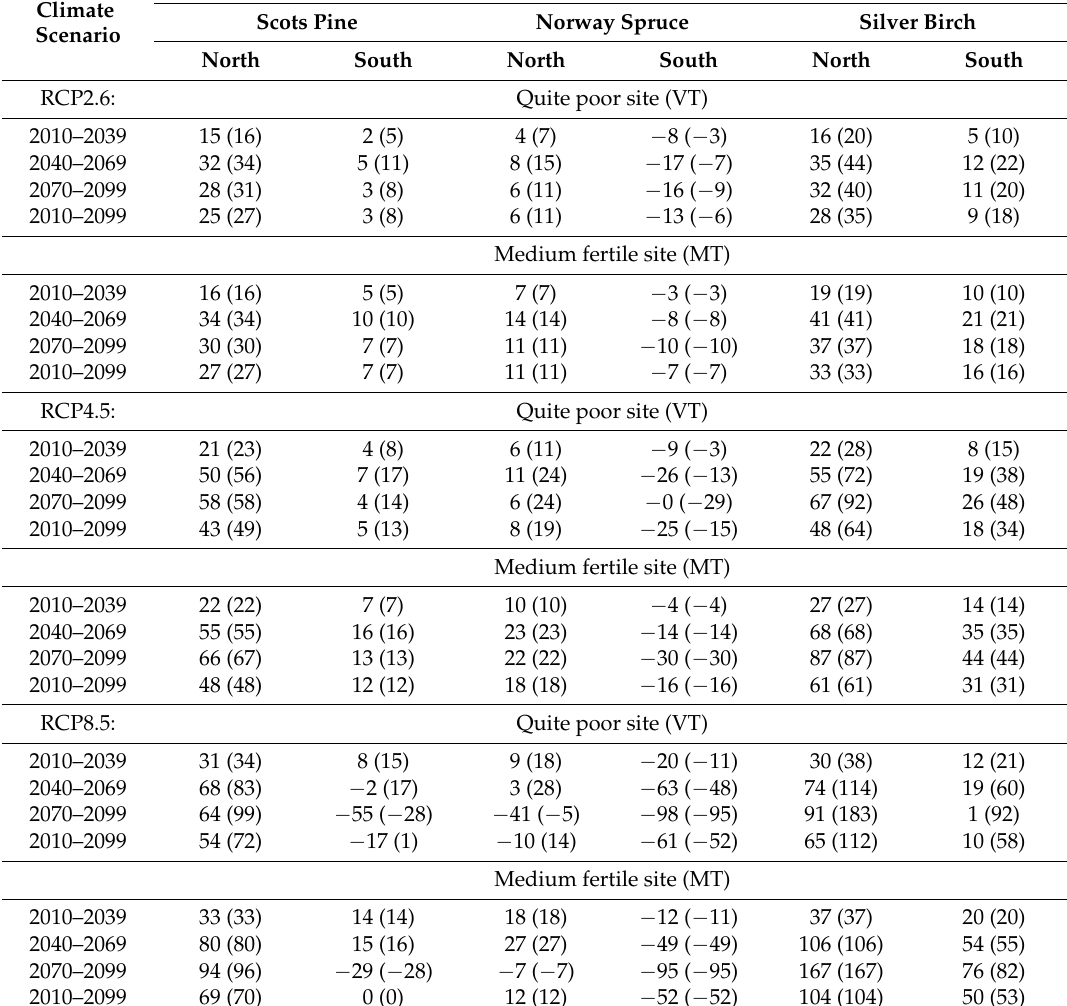
Table 5. Mean change in diameter growth on quite poor (VT) and medium fertile (MT) upland sites in different tree species in the south (Tampere, 61 ◦ N) and north (Rovaniemi, 66 ◦ N) under minor (RCP2.6), moderate (RCP4.5), and severe (RCP8.5) climate change scenarios in relation to the current climate. Numbers in parentheses indicate response for corresponding peatland sites (no